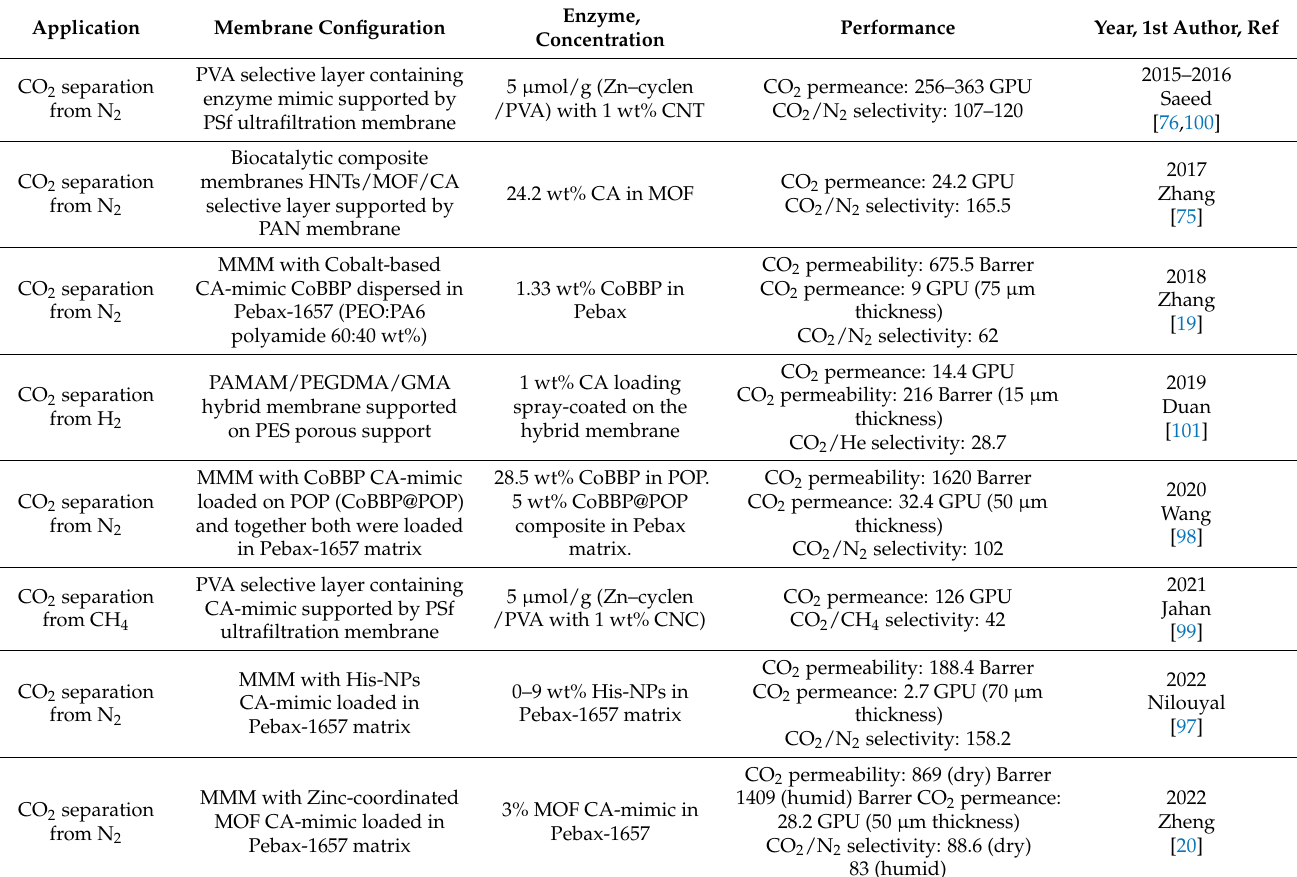
Table 1. Facilitated transport membranes with carbonic anhydrase or enzyme mimics for CO 2